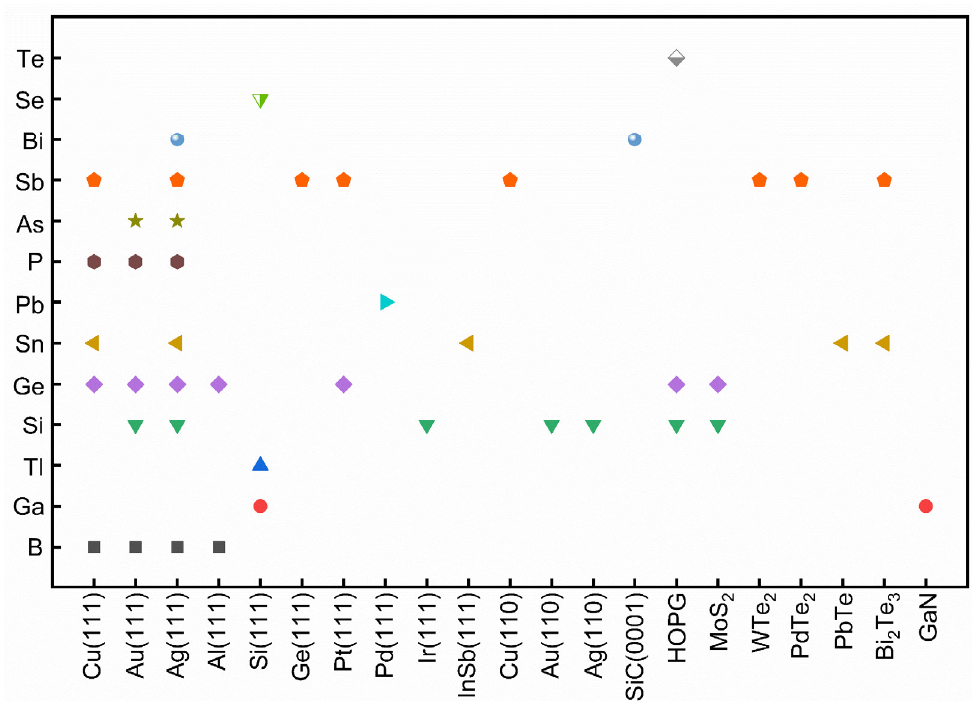
Figure 3. Summary of the successful substrate choices for the epitaxial growth of various non-graphene 2D Xenes. Each color represents one kind of Xenes.